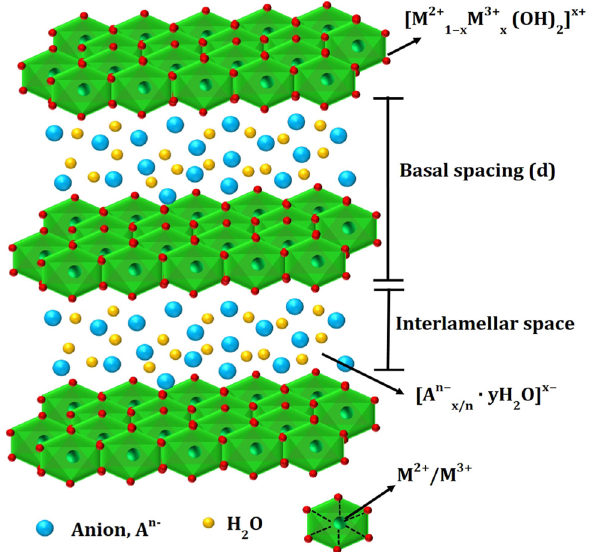
Figure 1: Structure of an LDH. Reproduced with permission from ref. [ 50 ] ; copyright ( 2018 ) ,